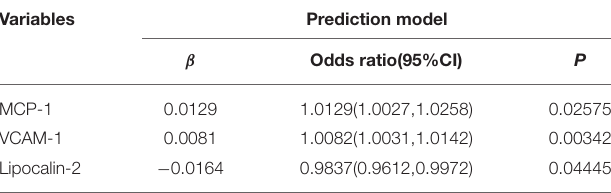
TABLE 3 | Prediction factors for response to treatment.